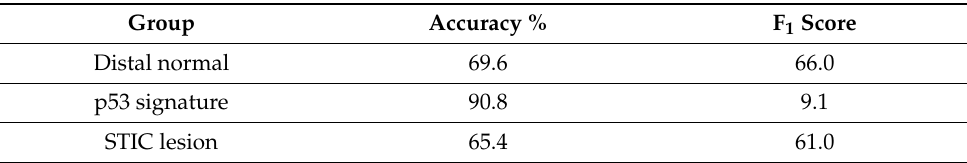
Table 2. The accuracies and F 1 scores for the OvR